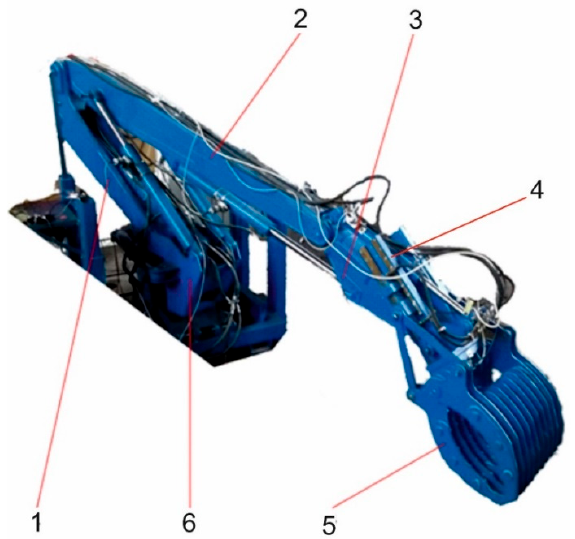
Figure 1. Tested manipulator with (1) boom, (2) arm, (3) forearm, (4) grapple rotation, (5) grapple opening and (6) base swing. opening and (6) base